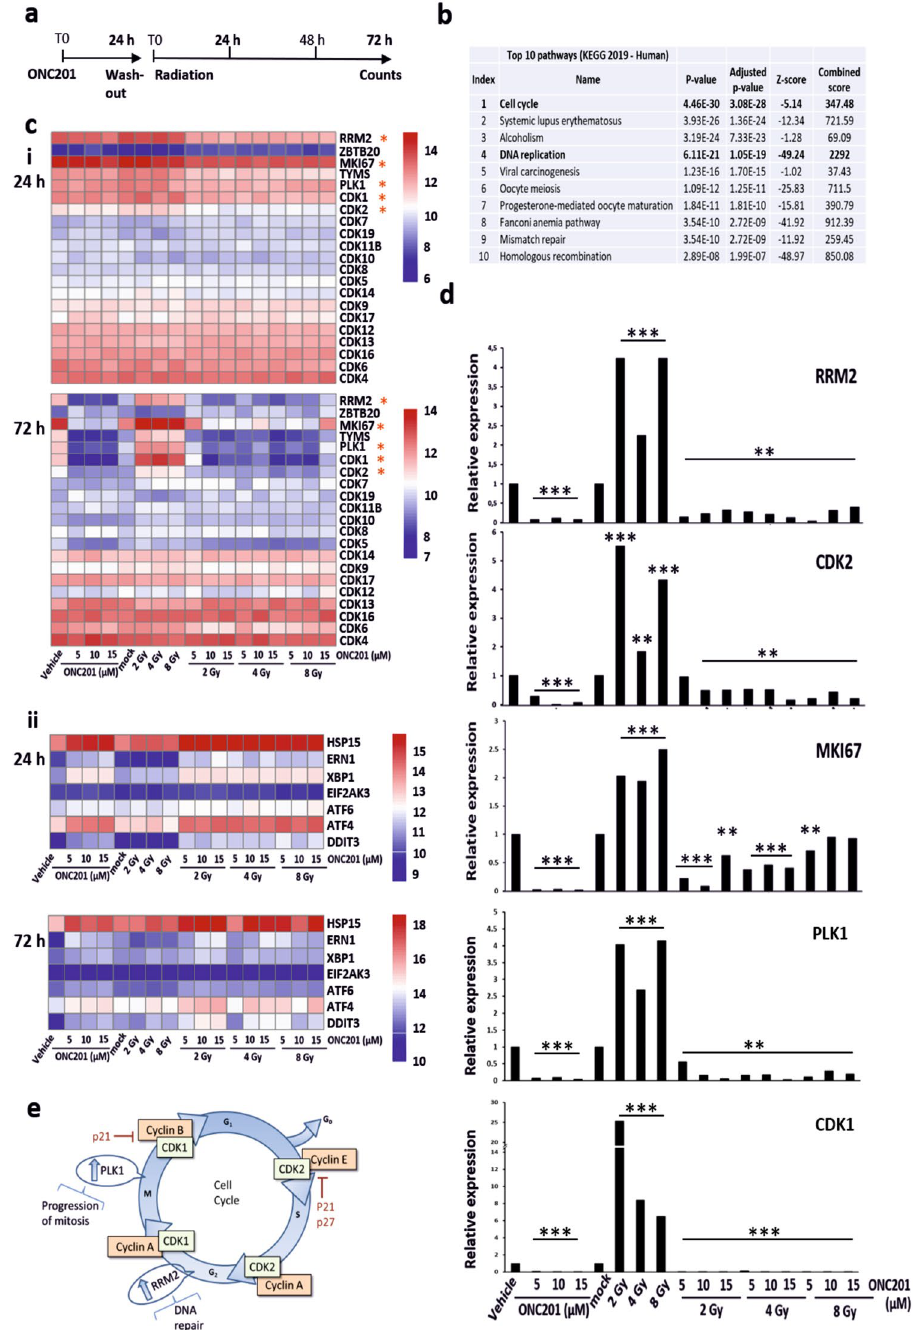
Figure 3. RNA-Seq analysis reveals that ONC201 restricts the expression of cell cycle progression and DNA repair pathway genes. ( a ) Schematic representation of the treatment in which PC3 cells have been primed with ONC201 before being radiated with single doses of Xrad (CorelDRAW Graphics Suite 2019, 64-Bit). ( b ) Pathway analysis of our genes of interest in KEGG Human 2019 pathway database, after RNA-seq analysis of PC3 cells treated as shown in ( a ), revealed that the most impacted pathway is cell cycle related (iEnrichr web tool 66,67 ). ( c ) Heatmaps analysis of RNAseq data (log2 of gene counts) of PC3 cells treated as shown in ( a ). Cells were harvested at 24 h ( c , i and ii top) and 72 h after the irradiation ( c , i and ii bottom). The genes listed are the most differentially regulated (see Methods for details on the analysis with RStudio software, Version 1.2.5033, release name "Orange Blossom" (RStudio Team (2020). RStudio: Integrated Development for R. RStudio, PBC, Boston, MA URL http://www.rstud io.com/). ( d ) Validation through TR-PCR of the five most relevant and differentially regulated genes at 72 h from the final radiation dose (RRM2, CDK2, PLK1, MKI67, CDK1). One-way ANOVA test has been run comparing treated vs Vehicle and No Radiation on n = 3 experiments, **p < 0.01; ***p < 0.001 (± SD). ( e ) Schematic representation of the cell cycle check points (RRM2, CDK2, PLK1, MIK67, CDK1) were drawn utilizing CorelDRAW Graphics Suite (CorelDRAW Graphics Suite 2019,